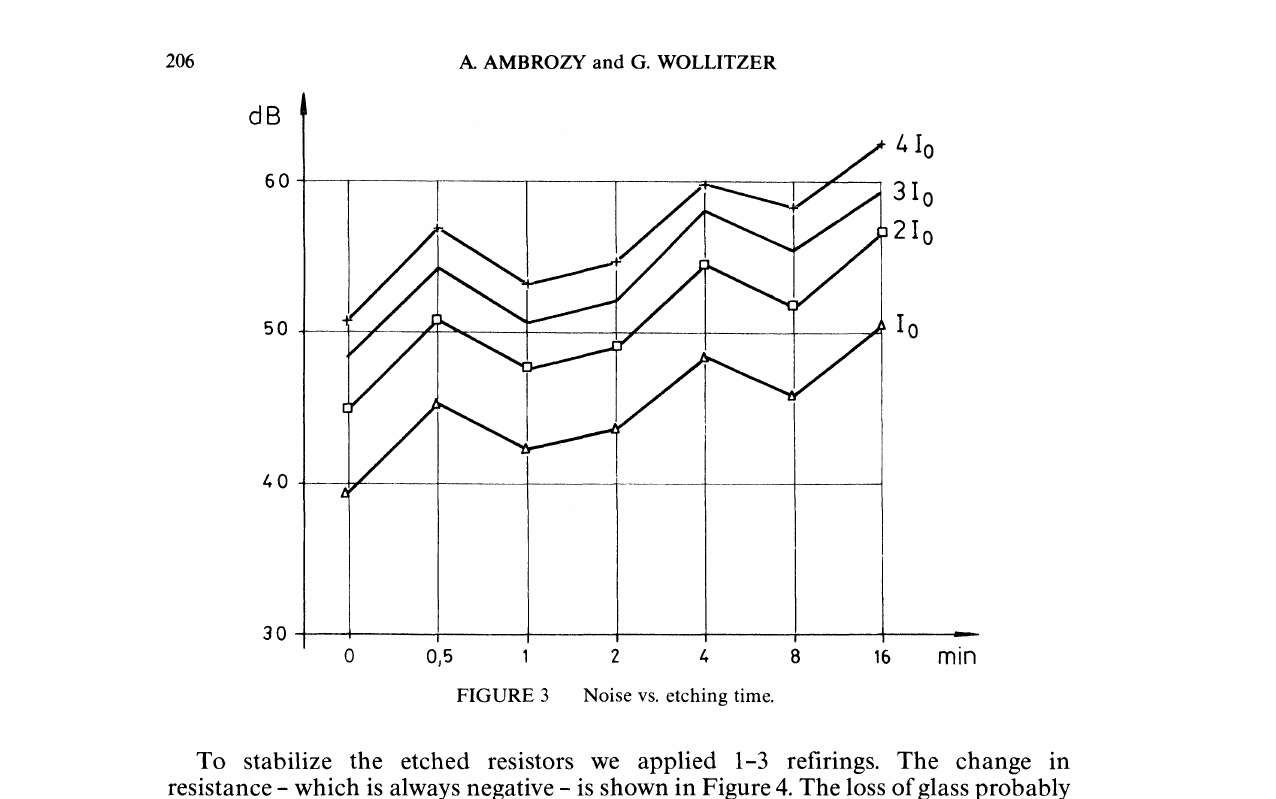
FIGURE 3 Noise vs. etching time.